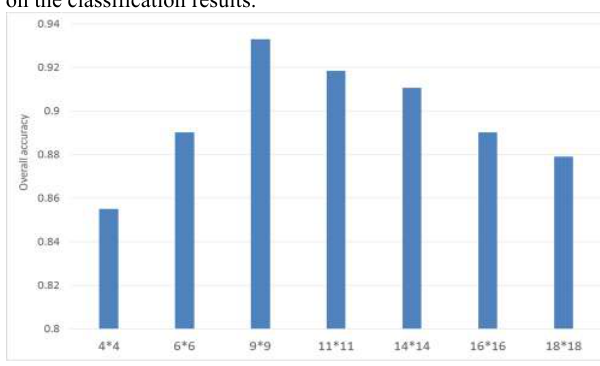
Figure 4. Classification accuracy chart with different window sizes